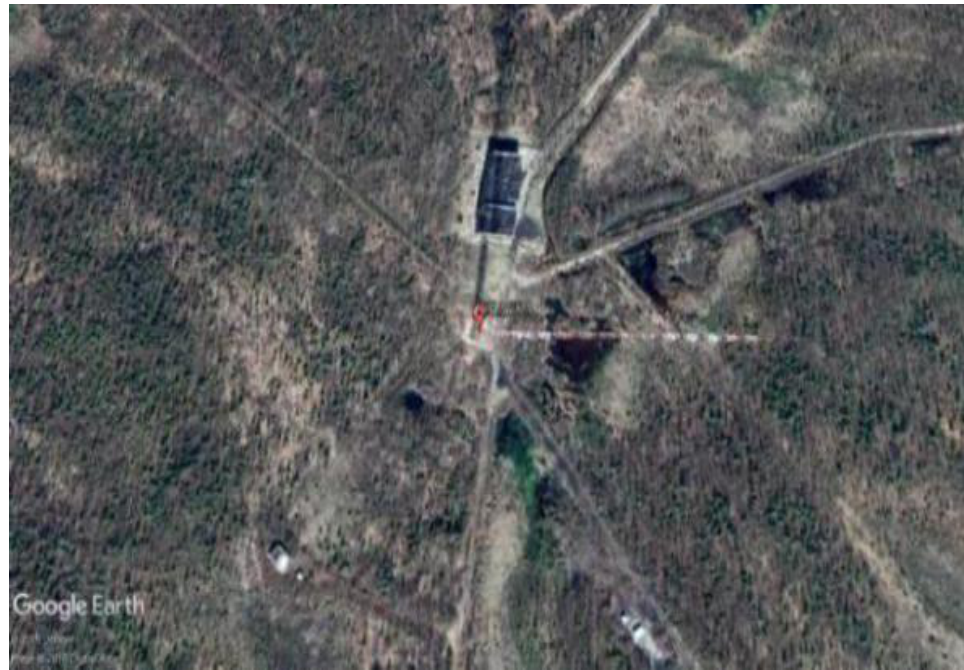
Figure 4. Satellite image of a Chayka system transmitting antenna in Russia.